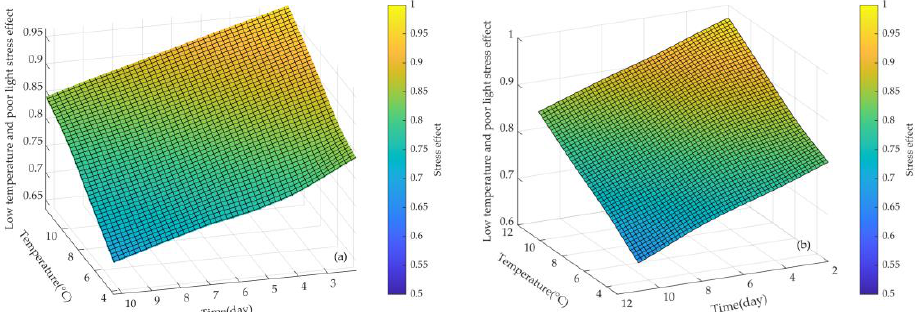
Figure 1. Simulation model of LT and PL stress effect. ( a ) Three-dimensional figure of stress effects with temperature and time under the 400 µ mol · m − 2 · s − 1 poor light; ( b ) 3D figure of stress effects with temperature and time under the 200 µ mol · m − 2 · s − 1 poor light.